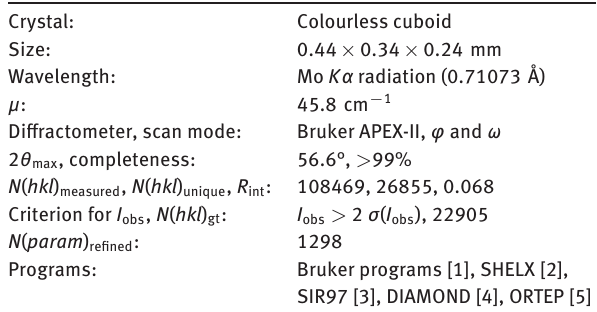
Table 1: Data collection and